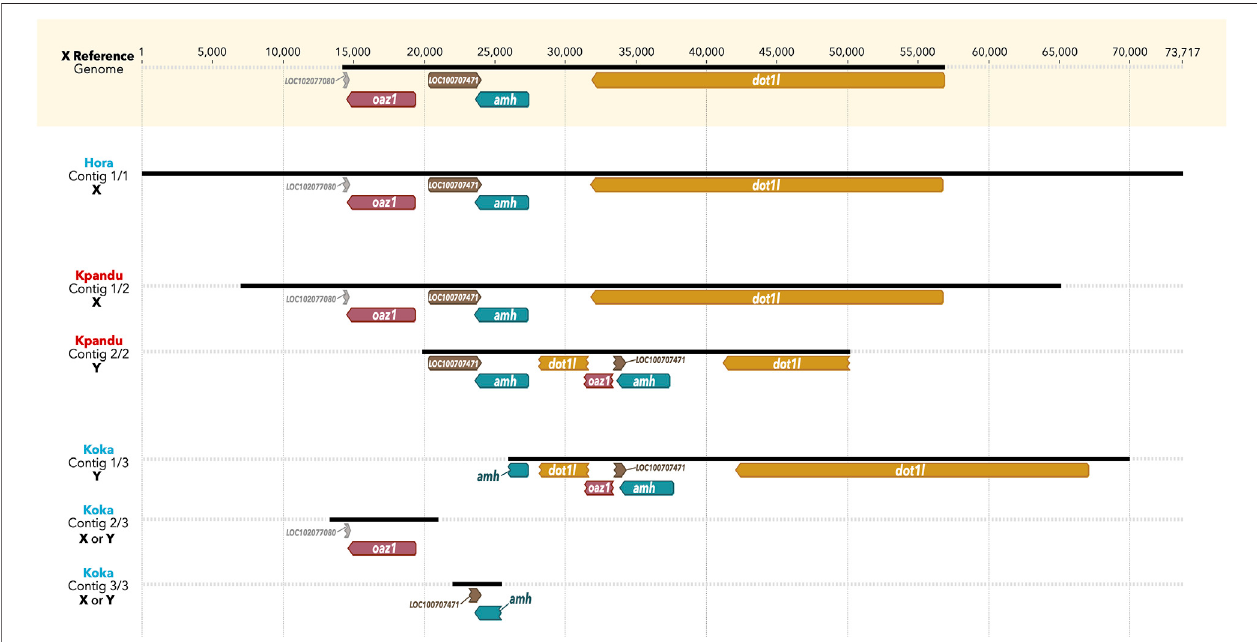
FIGURE4| ContigsoutputoftheCanu denovo assemblyofthethreemales belongingtothewildpopulations ofHora,Kokaand Kpandu.Koka andHora(in blue) are Ethiopianmales from lakesofthe same names, whereasKpandu (inred) isfrom LakeVolta inGhana. All contigs arevisuallyaligned tothe oaz1 geneofthe reference genome, based on Geneious automated annotations from the XX reference genome and from the expected Y haplotype built previously. X and Y labels of contigs are deduced according to the structure of contigs, presenting or not the dot1l-oaz1 chimera, speci fi c to the Y haplotype as described in Triay et al. (2020).